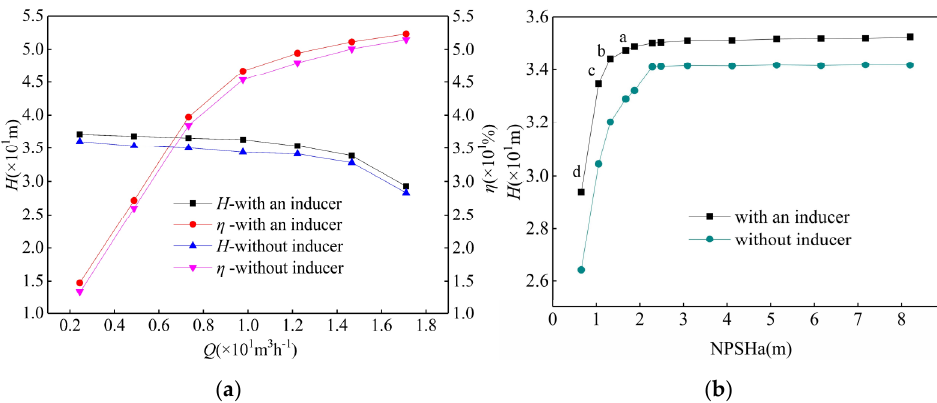
Figure 4. Performance comparison of centrifugal pumps with an inducer and without inducer: ( a ) External performance curve; ( b ) Cavitation performance curve at Q d .